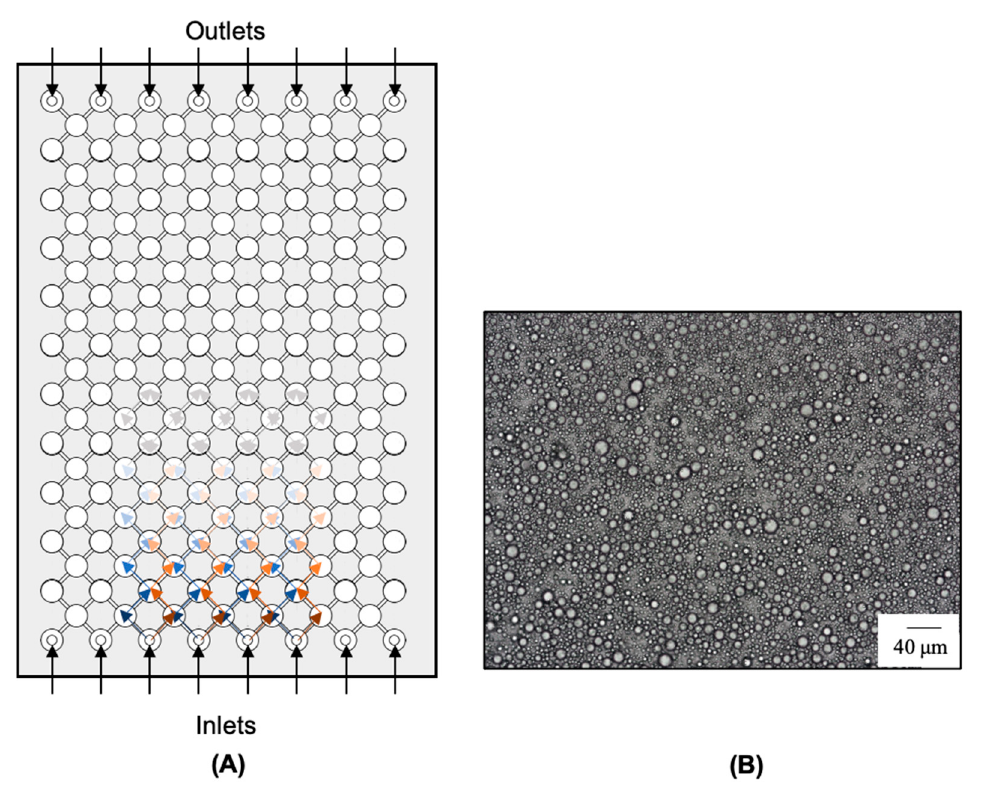
Figure 9. Schematisation of the mesostructured static mixer—NETmix ( A ) with the representation of the fluid streams inside of the reactor, and an example of PE produced via NETmix (( B ). (Reprinted from [144], Copyright (2021), with permission from Elsevier).